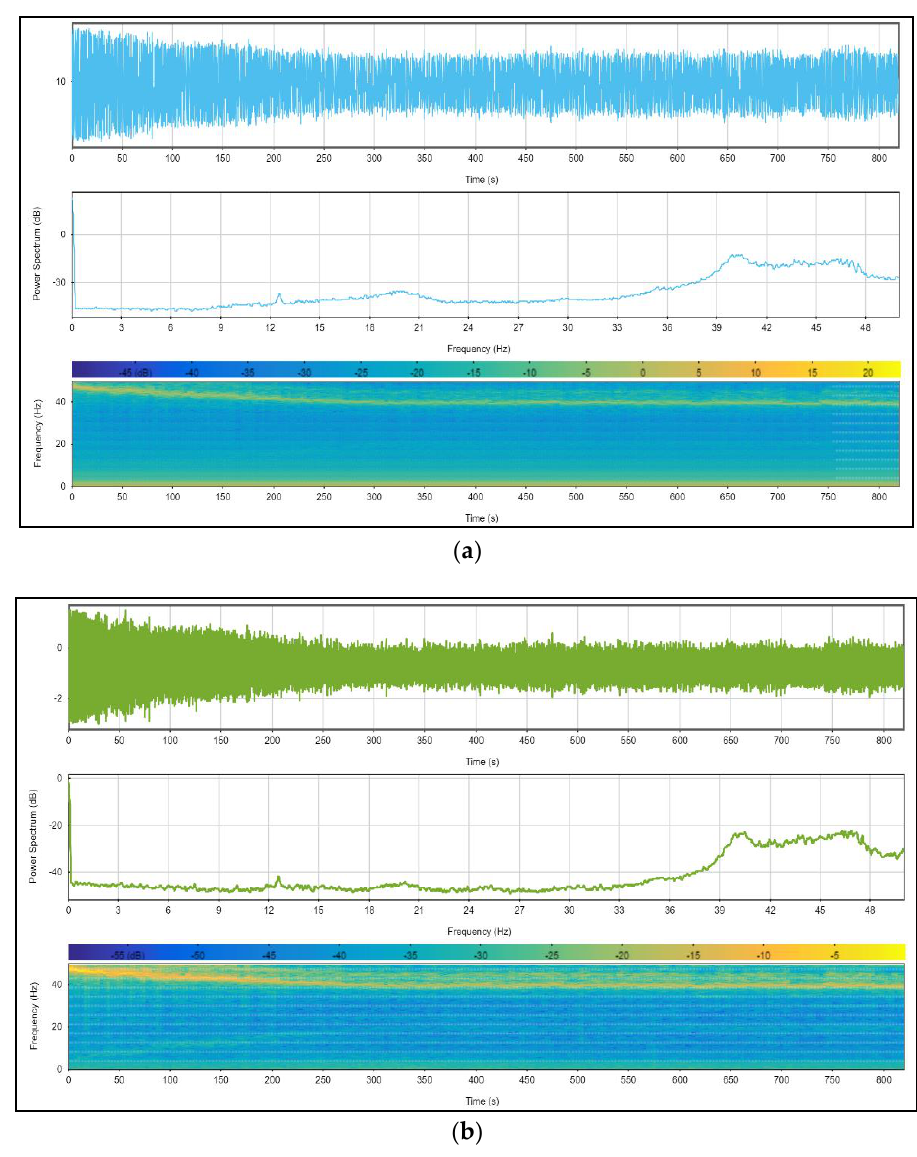
Figure 9. Illustration of spectrograms of “Ax” ( a ) and “Az” ( b ) IMU signals (signal on the top, power spectral density in the middle, and the signal spectrogram at the bottom).